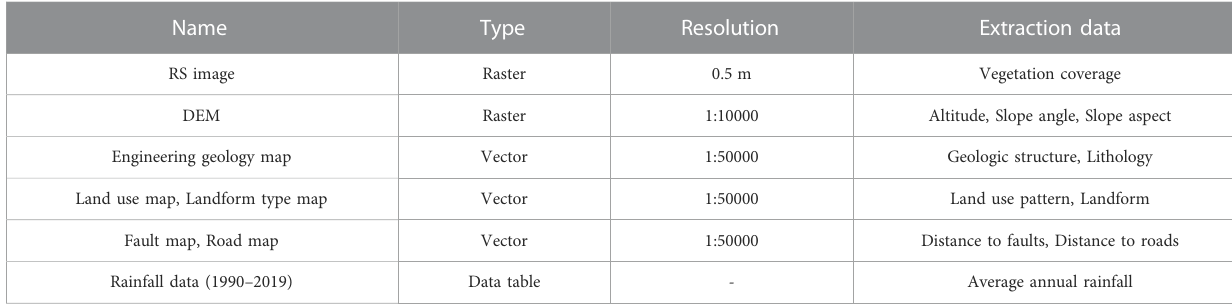
TABLE 1 Basic data of the study